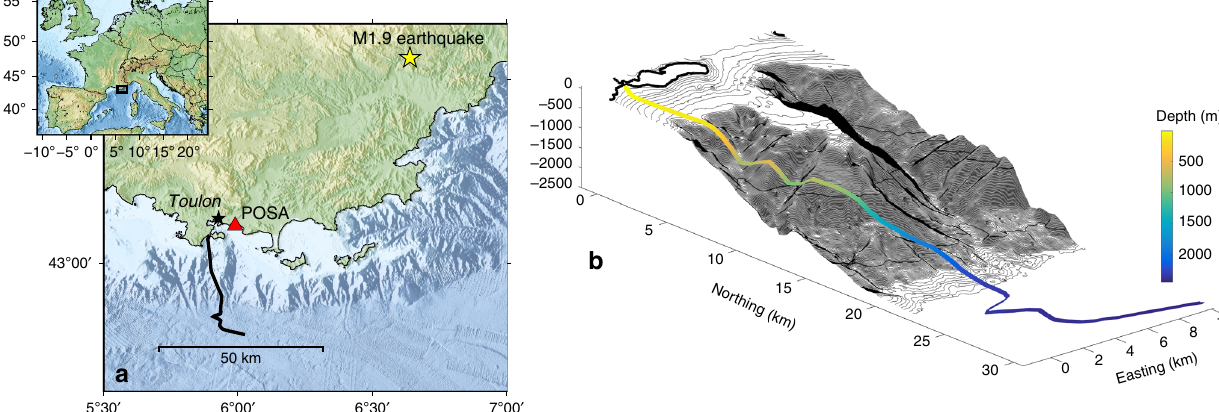
Fig. 1 Map and perspective view of the sea fl oor MEUST-NUMerEnv cable. The optic fi ber cable offshore Toulon, France, shown in a map view and b 3D view. The 41.5 km long optical fi ber crosses several oceanic domains: the shallow continental shelf, the steep continental slope and the deep oceanic plain. The yellow star on the map indicates the location of a magnitude 1.9 earthquake. The red triangle is the permanent seismic station